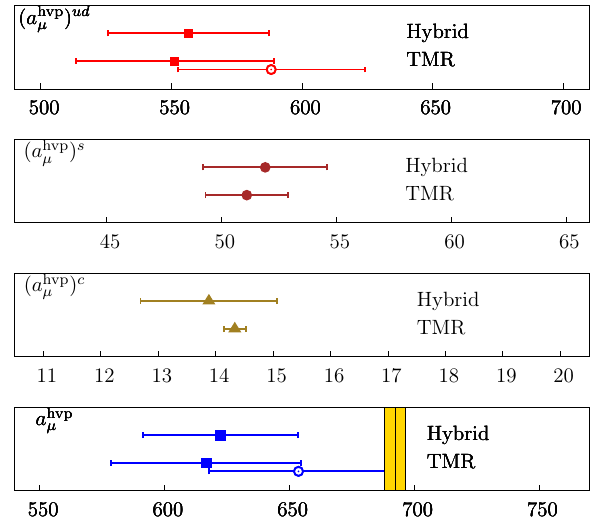
Figure 4 . Comparison of results for the di(cid:11)erent (cid:13)avour contributions to a hvp